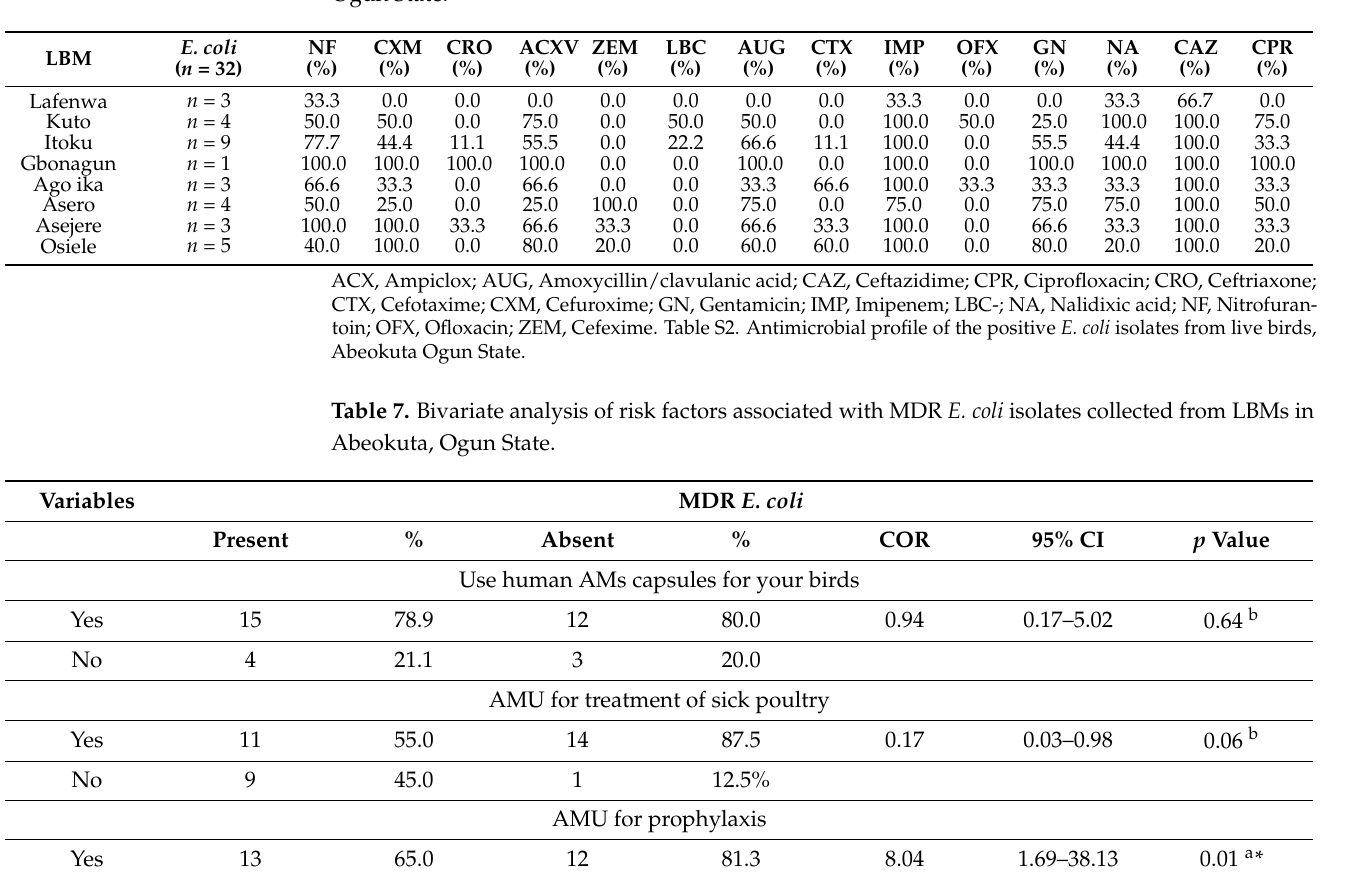
Figure 6. The rates of antimicrobial susceptibility and resistance pattern of putative positive E. coli to 14 antimicrobials tested. ACX, Ampiclox; AUG, Amoxycillin/clavulanic acid; CAZ, Ceftazidime; CPR, Ciprofloxacin; CRO, Ceftriaxone; CTX, Cefotaxime; CXM, Cefuroxime; GN, Gentamicin; IMP, Imipenem; LBC-; NA, Nalidixic acid; NF, Nitrofurantoin; OFX, Ofloxacin; ZEM, Cefexime. Table 6. The Antimicrobial resistance among E. coli isolates from the eight LBMs in Abeokuta, Ogun State.